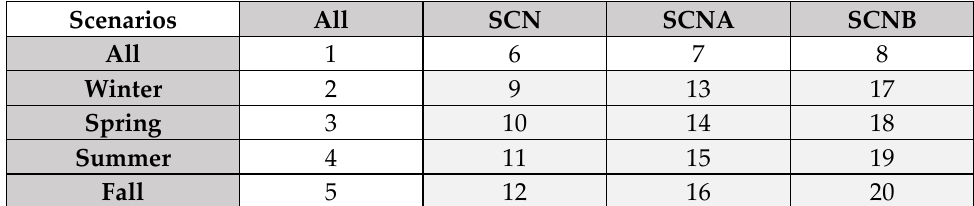
Table 2. Number of scenarios suggested in the development of global and specific classification models considering the effect of seasonality and beam modes.